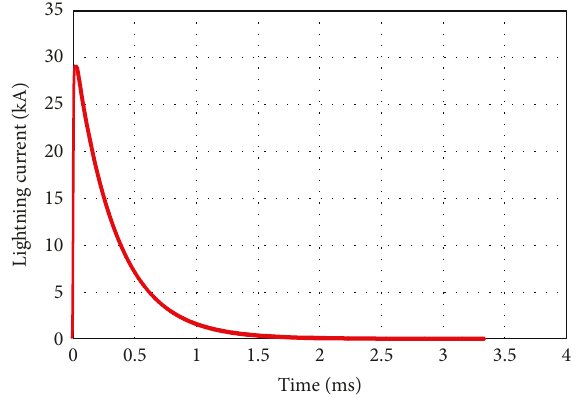
Figure 10: 16-mesh simulation model of the irregular grounding